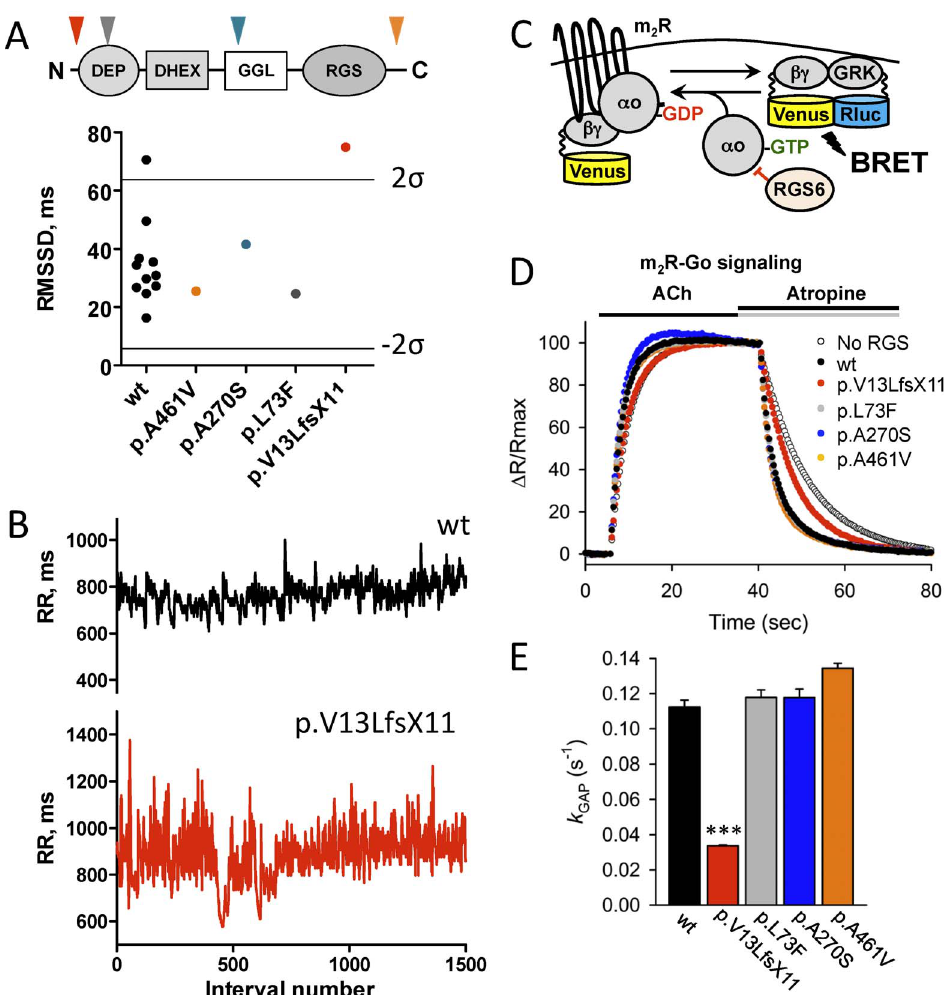
Figure 5. Abnormal sinus arrhythmia in a human subject with dysfunctional RGS6. A, HRV measured in humans carrying variants in RGS6 and 11 age-matched control subjects (wt, black). Lines represent upper (2 s ) and lower ( 2 2 s ) 95% confidence thresholds as determined by the 2 s rule. Insert : domain structure of RGS6 protein. Arrows show localization of corresponding variants. B, Representative tachograms of RR intervals from a control subject (black) and a subject heterozygous for the p.Val13LeufsX11 variant in the RGS6 gene (red) determined from continuous Holter recordings. C, Schematics of the assay design to study effects of mutations on the RGS6 function. Stimulation of the m 2 R by ACh results in the dissociation of G m o from the heterotrimer. Released G bc subunits tagged with Venus become available for the interaction with Nluc8-tagged GRK reporter producing the BRET signal. D. Representative responses to sequential application of ACh (10 m M) and atropine (1 mM) recorded in the presence of the indicated constructs. The BRET signals averaged from 4 experiments were plotted as individual data points. E , Catalytic activity of RGS6 defined by the k GAP parameter. To determine the k GAP values, the deactivation rate constant measured in the absence of RGS6 was subtracted from values measured in the presence of RGS6. Symbols: ***, p , 0.001